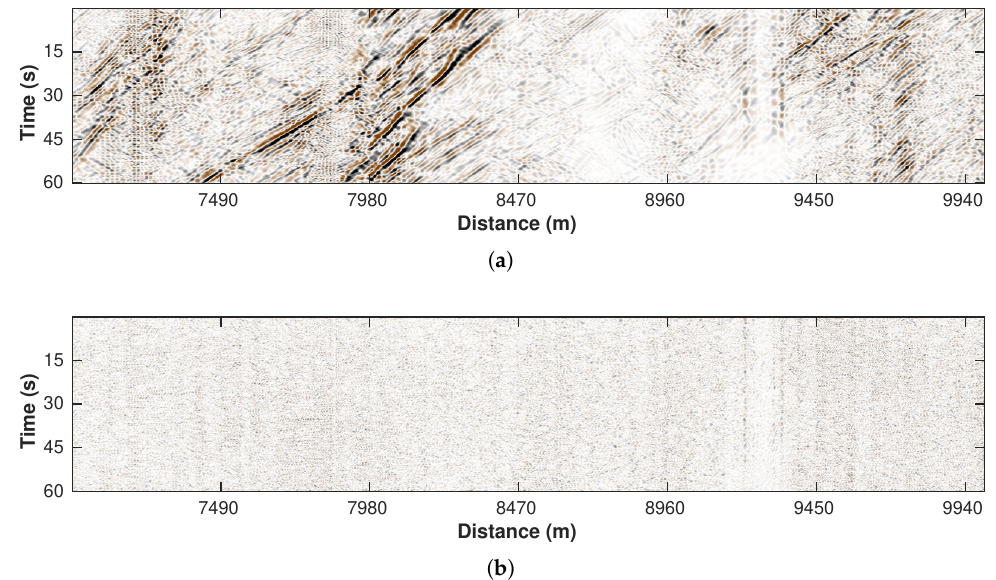
Figure 12. Processing results of curvelet transform. ( a ) Filtered data. ( b ) Removed noise